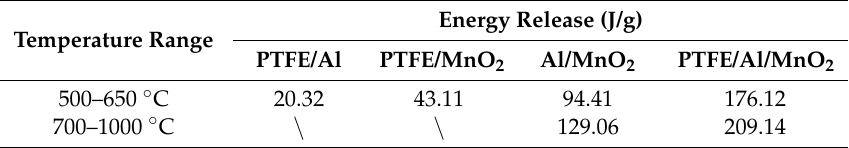
Table 3. Energy release values during the exothermic reactions of the four